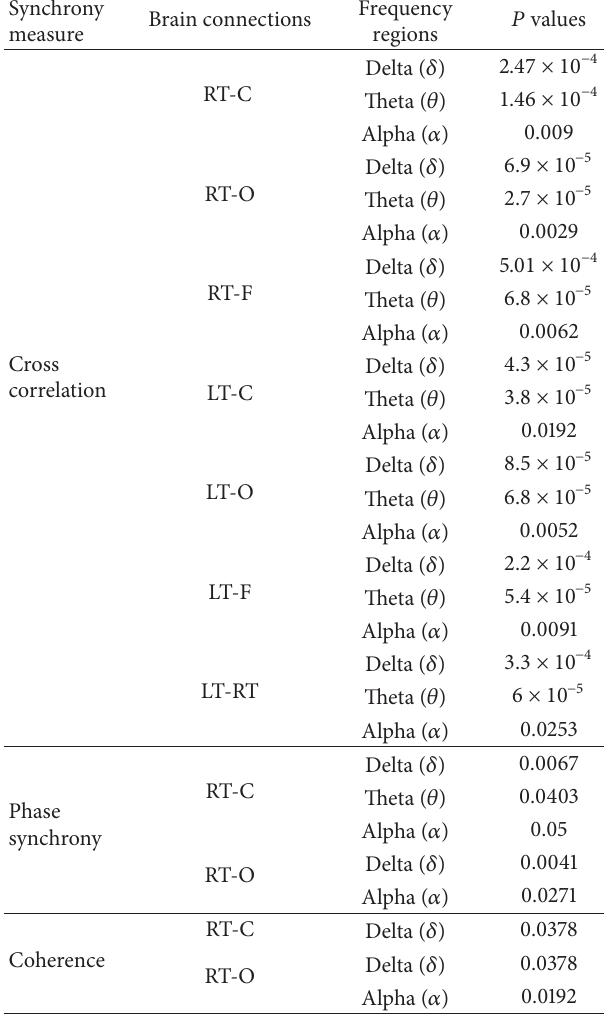
Table1: 𝑃 valuesfor datasetA ,differentfrequencybandsindifferent brain connections.